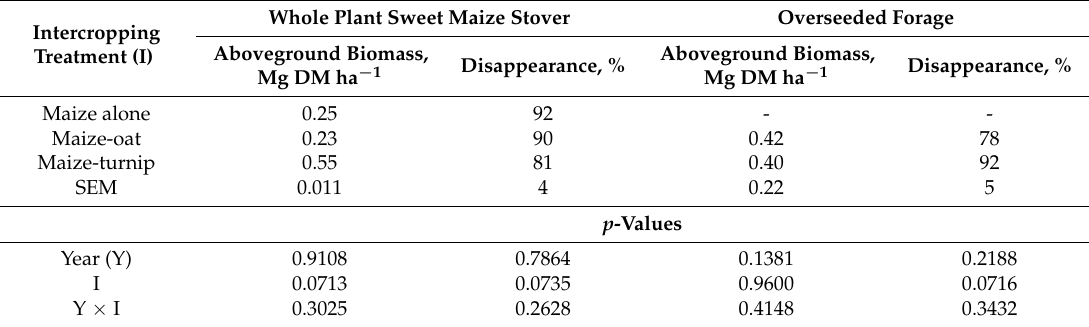
Table 3. Relay intercropping treatment main effect means of post-grazing aboveground biomass dry matter (DM) yield and percent disappearance of sweet maize stover alone or intercropped with oat or turnip and the intercropping forage species over two years at Alcalde, NM 1